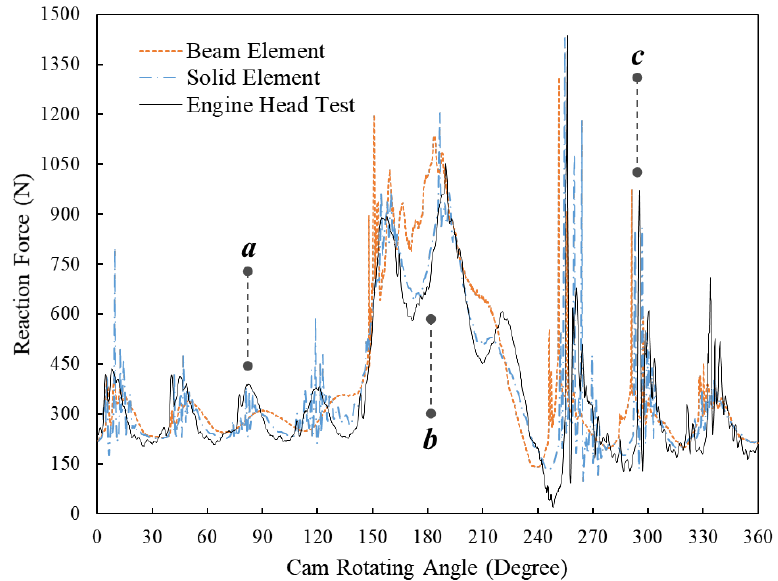
Figure 7. Comparison between the spring reaction forces at 8000 RPM engine speed of the dynamic FE results using beam elements and solid elements and the results of the engine head test.